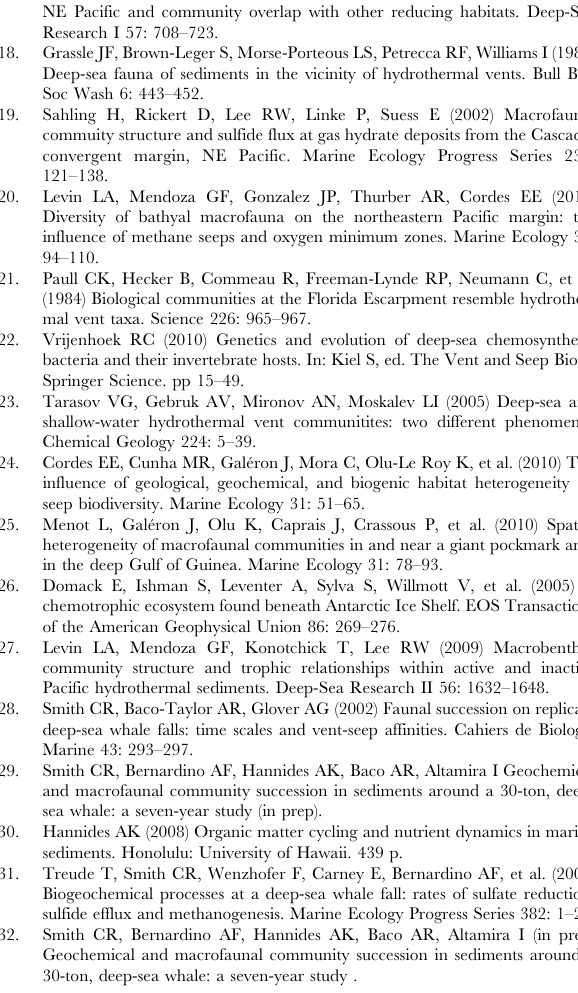
Table S1 Summary of comparable work on